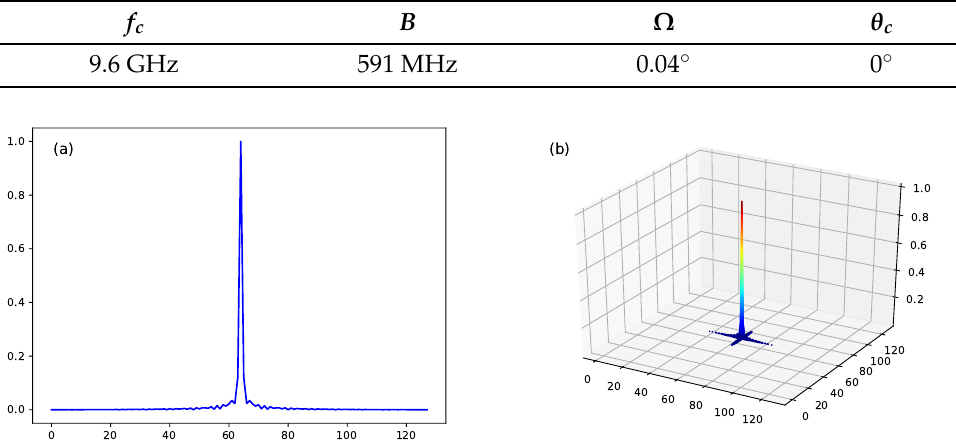
Table 2. Radar parameters.